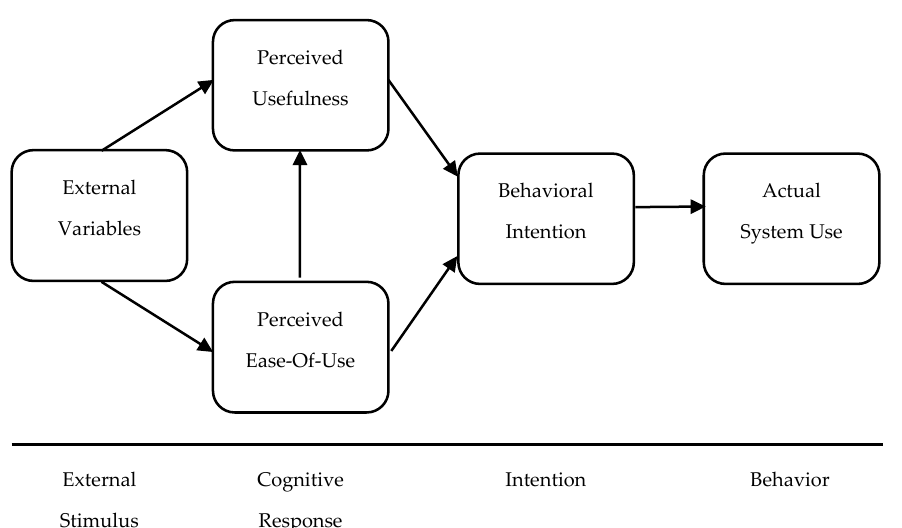
Figure 6. Structure of the TAM model. Reprinted with permission from ref. [31]. Copyright 1996 Elsevier.